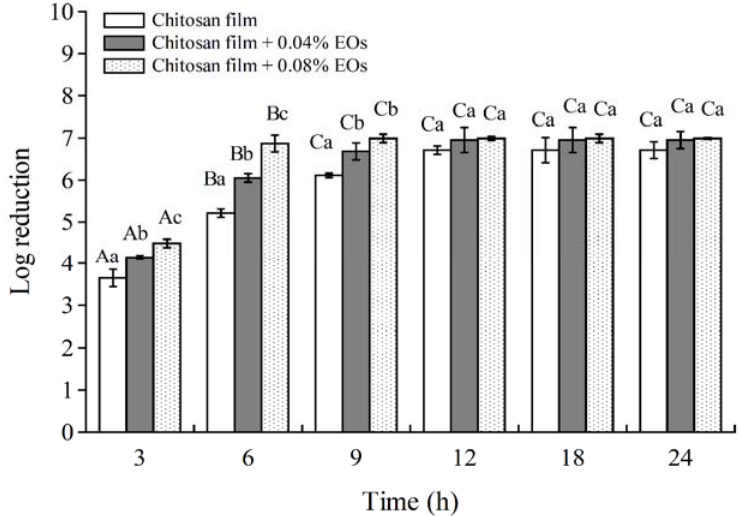
Figure 2. Antilisterial activity of chitosan film incorporated with EOF:EOH at 0.04:0.04 (Chitosan film + 0.04% EOs) and chitosan film incorporated with EOF:EOH at 0.08:0.08 (Chitosan film + 0.08% EOs). Error bars represent ± standard deviation from three replicates. Bars of the same treatment, followed by different capital letters indicate significant differences ( p ≤ 0.05 ). Bars of the same time followed by different small letters indicate significant differences ( p ≤ 0.05 ).